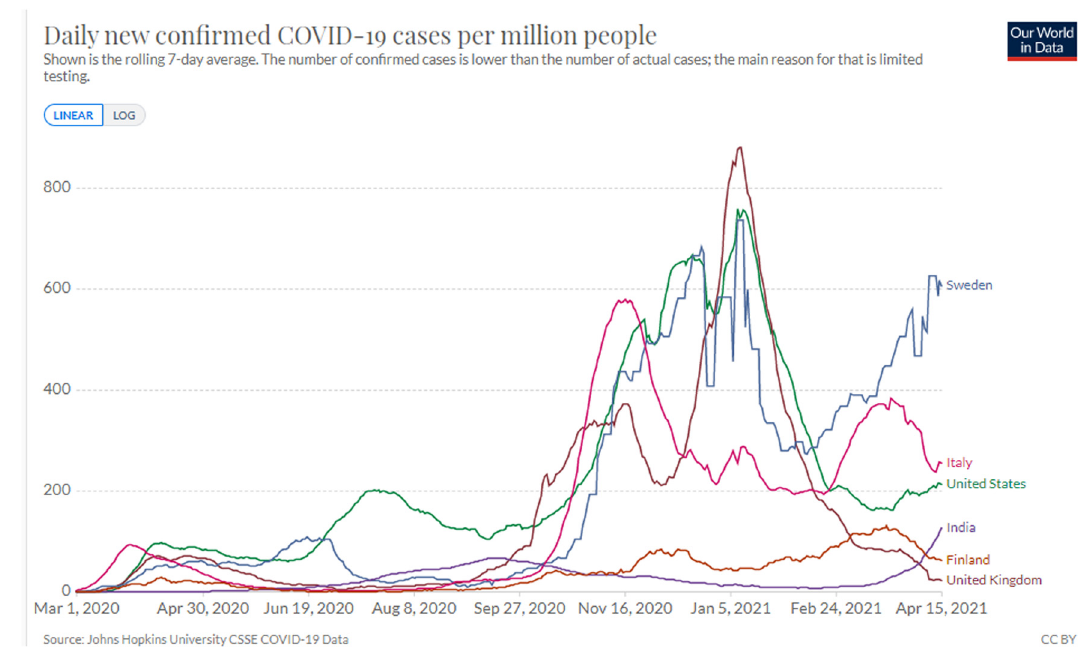
Figure 1: Daily new con fi rmed COVID - 19 cases per million people, rolling 7 - day averages collected from [ 13 ] for selected